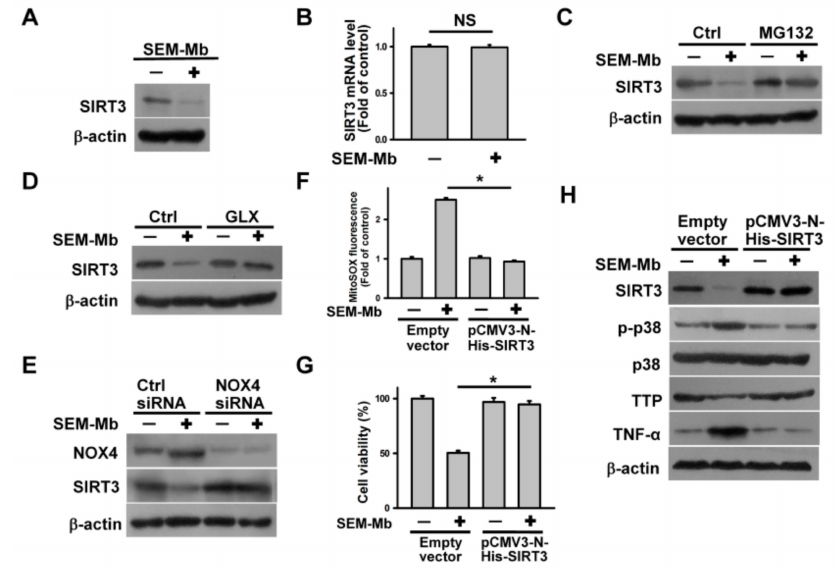
Figure 6. NOX4-mediated SIRT3 degradation regulated p38 MAPK/TTP axis-dependent TNF-